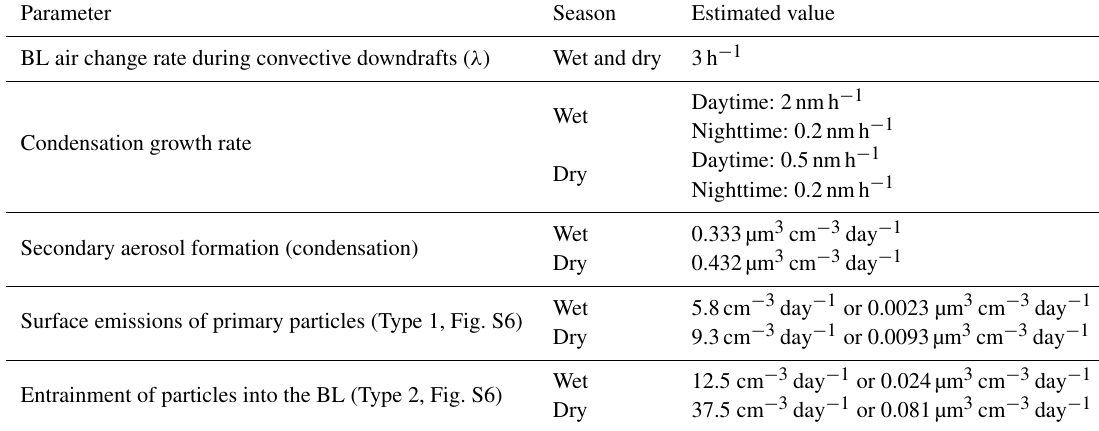
Table 2. Model fitted parameters and their estimated values for the wet and dry seasons. Fitted condensation growth rates are shown for daytime (06:00 to 18:00LT) and nighttime (18:00 to 06:00LT). The contribution of the different particle sources is given as an effective daily concentration contribution to the lowermost 1000m of the